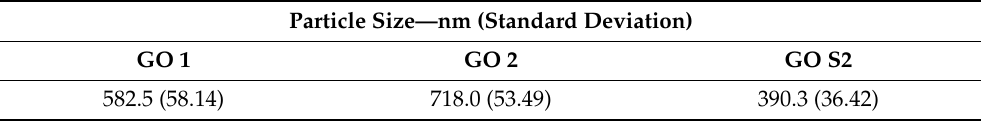
Table 2. Particle size results from dynamic light scattering (DLS).